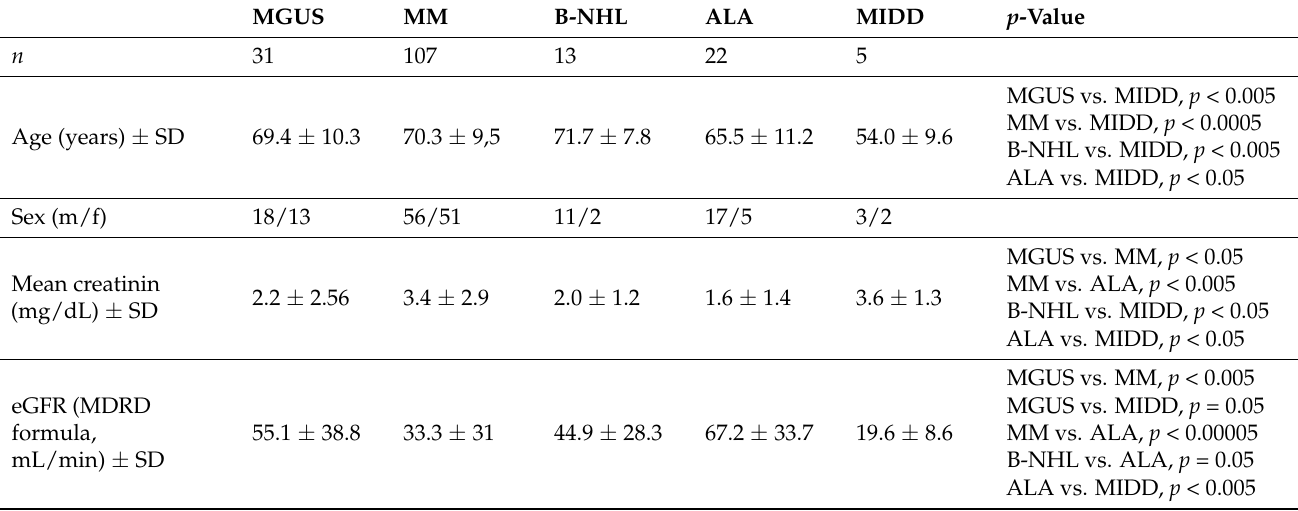
Table 3. Clinical characteristics after